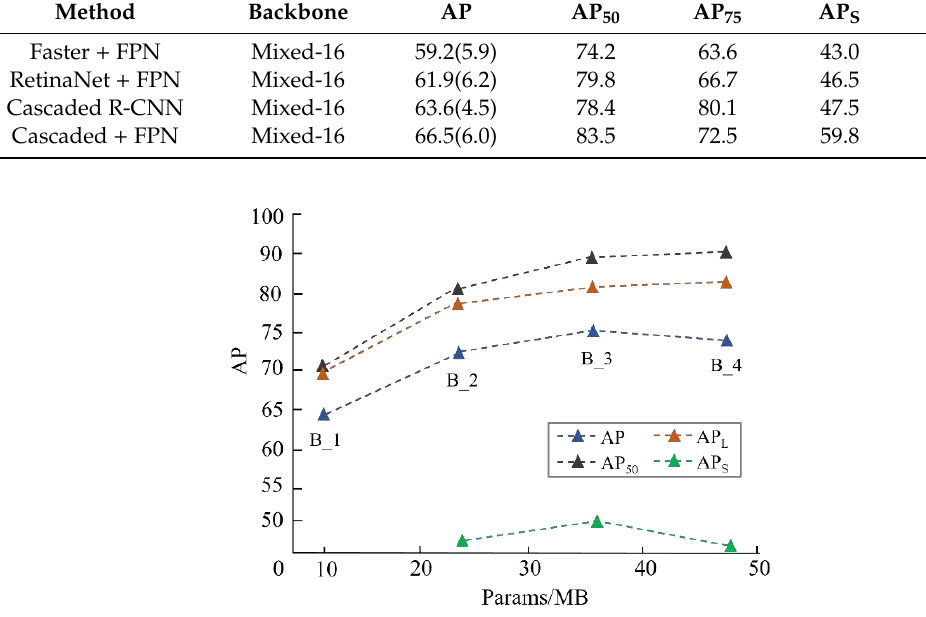
Table 6. Performance of CG-RPN with di ff erent center-ness threshold